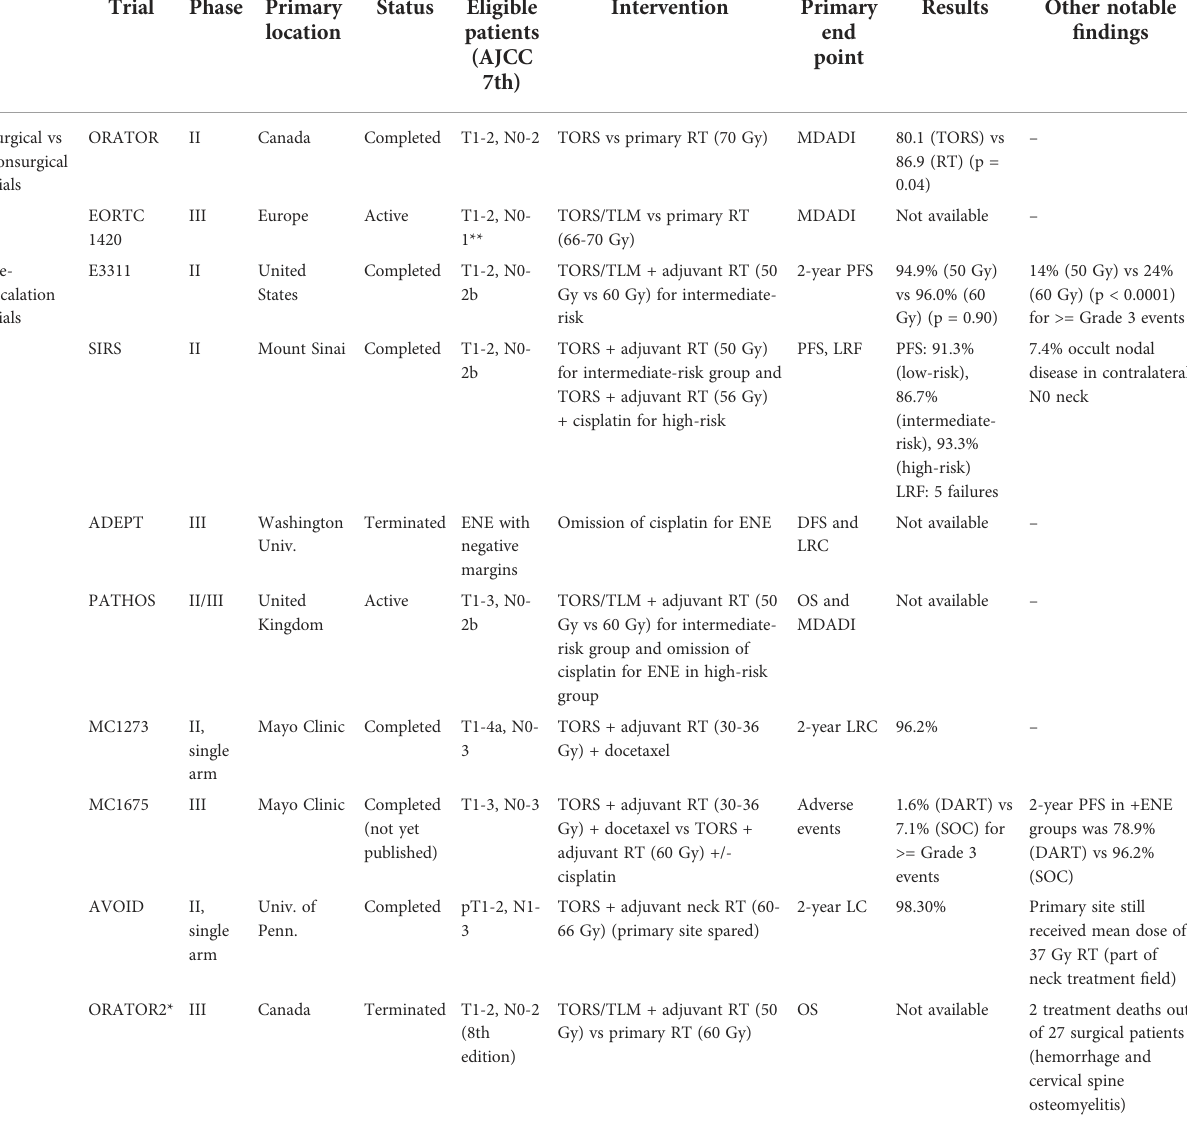
TABLE 1 Surgical clinical trials for HPV-mediated oropharyngeal